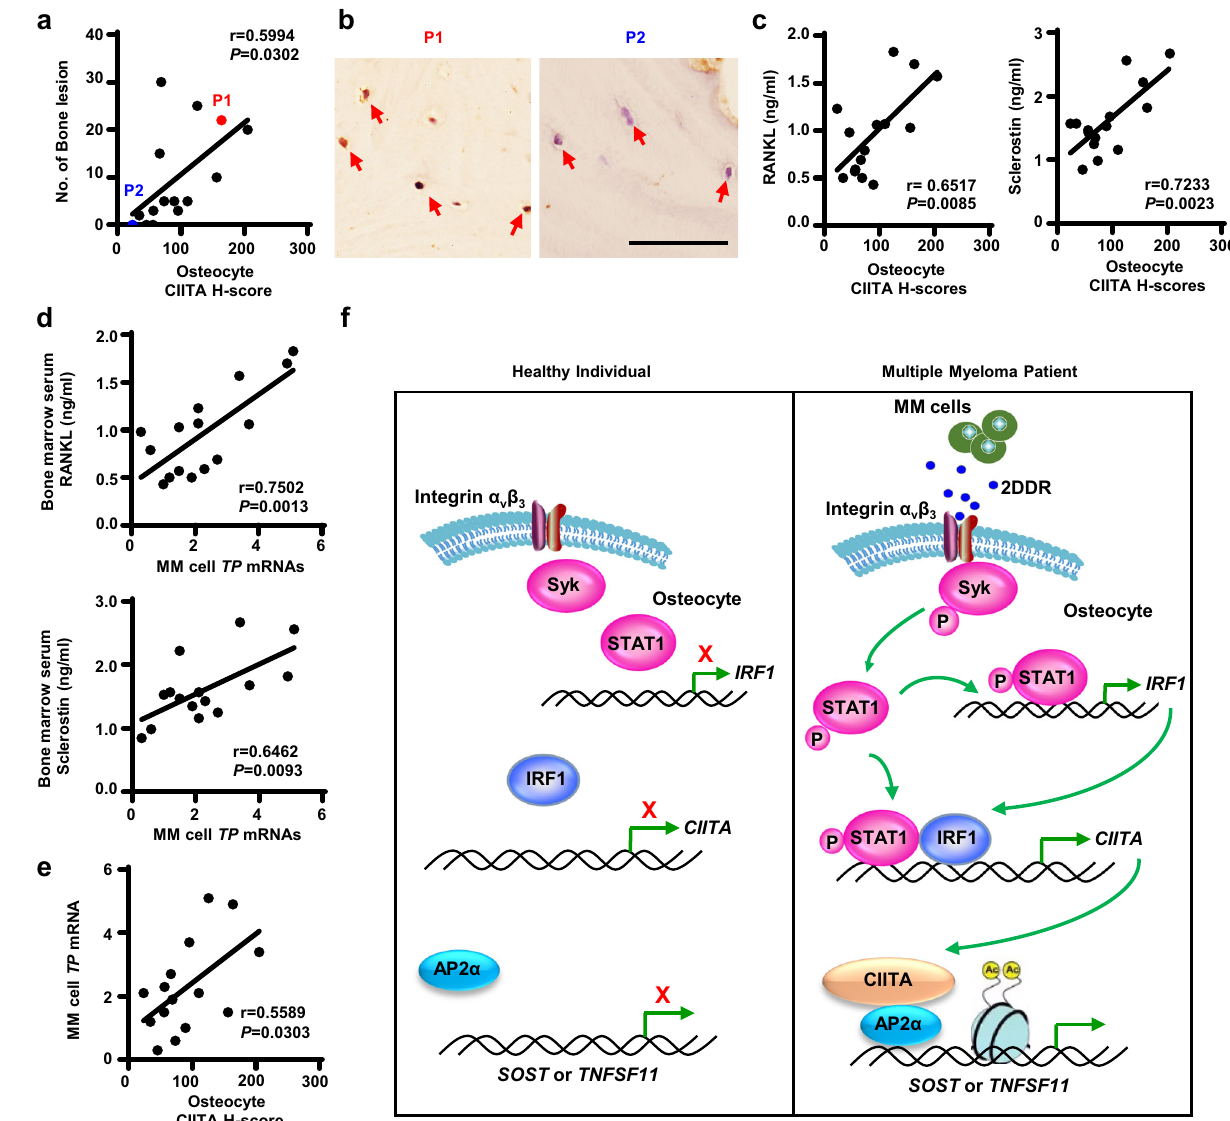
Fig. 7 Expression levels of CIITA in osteocytes are associated with the status of bone lesions in myeloma patients. Bone marrow biopsies were randomly collected from myeloma patients ( n = 15) and then stained with the anti-CIITA antibody. The immunohistochemically stained slides were semi- quanti fi ed by H-score, which re fl ects the totality of percentage of stained cells in each intensity. a Correlation between the H-scores of CIITA + osteocytes and the numbers of bone lesions in myeloma patients. b Representative images of immunohistochemical staining show the expression of CIITA in osteocytes in the biopsy segments of the two patients highlighted with red or blue in ( a ). Scale bar, 50 µ m. c – e Bone marrow aspirates of myeloma patients were subjected to ELISA. Shown are the correlation coef fi cients of the H-scores of CIITA + osteocytes with bone marrow serum levels of RANKL ( c , left) or sclerostin ( c , right), the correlation coef fi cients of the levels of TP mRNA in myeloma cells with bone marrow serum levels of RANKL ( d , left) or sclerostin ( d , right), and the correlation coef fi cients of the H-scores of CIITA + osteocytes with the levels of TP mRNA in myeloma cells ( e ). The correlations were evaluated using Pearson coef fi cient with two-tailed P value. r, correlation coef fi cient. f Depiction of osteocyte CIITA – mediated bone destruction in multiple myeloma. Myeloma TP/2DDR upregulates CIITA expression in osteocytes through the STAT1/IRF1 signaling pathway. The increased CIITA via AP2 α as a link binds to the promoter of Tnfsf11 or Sost and activates histone acetylation at H3K14, leading to the expression of RANKL or sclerostin in